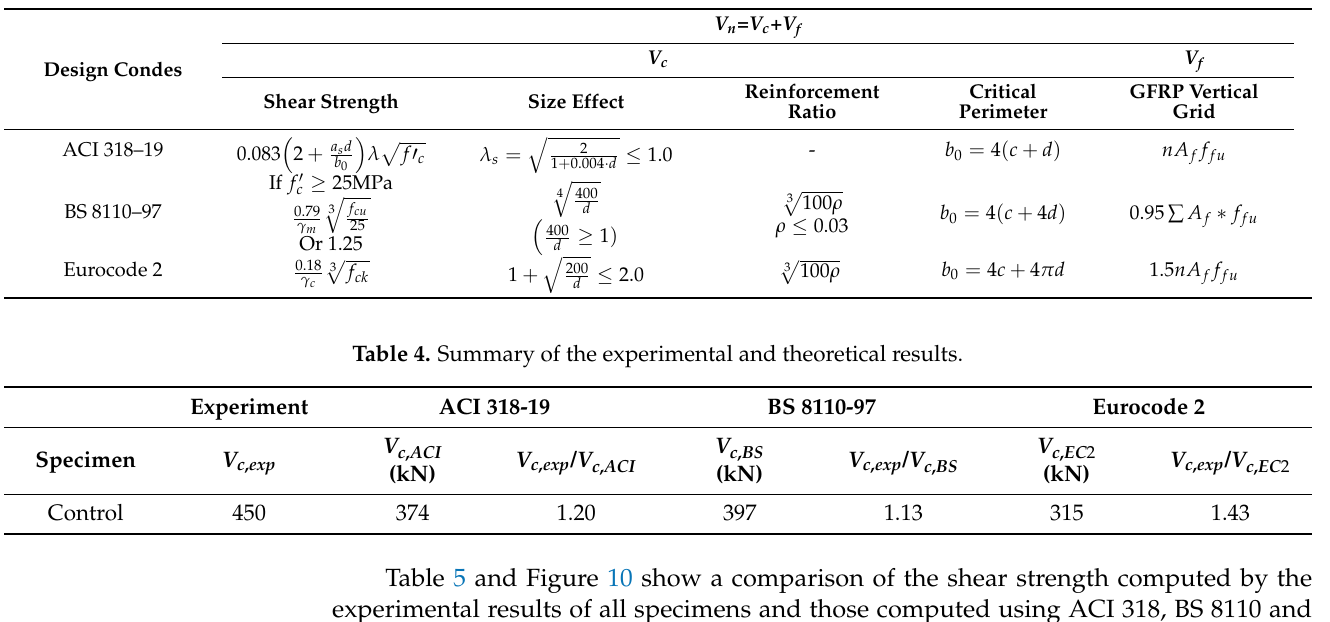
Table 3. Summary of shear strength equations provided by design codes.